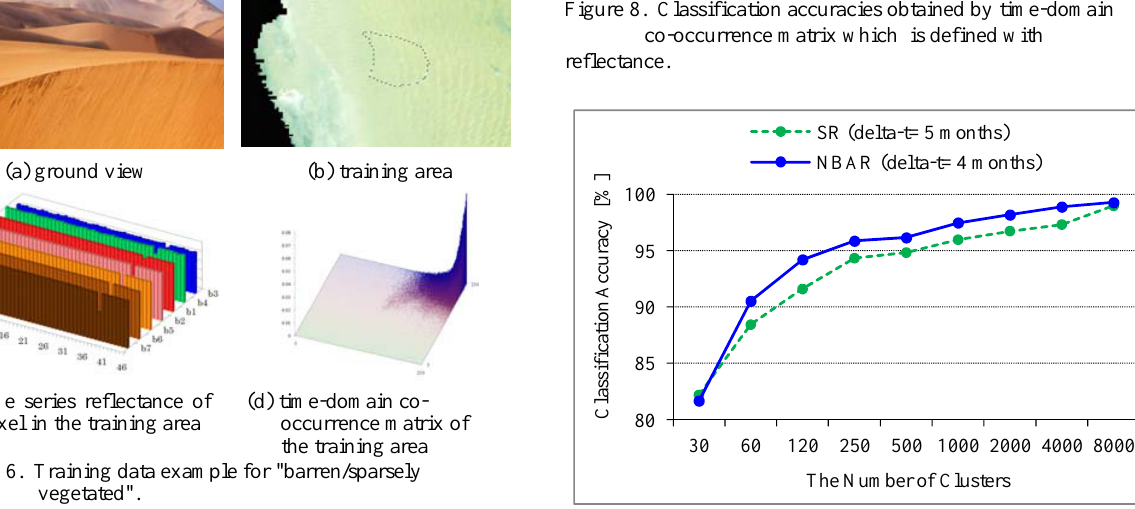
Figure 9. The relationship between the number of clusters and classification accuracies obtained by time-domain co-occurrence matrix which is defined with spectral